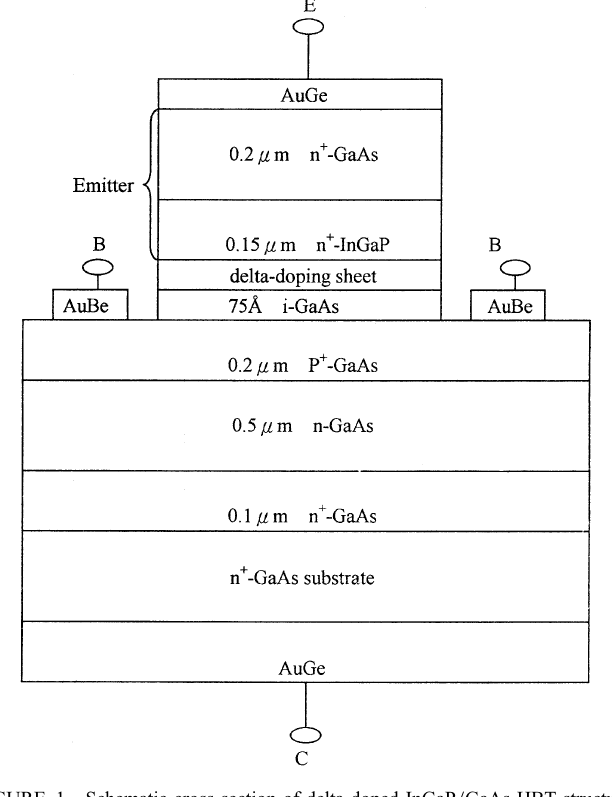
FIGURE 1 Schematic cross-section of delta-doped InGaP = GaAs HBT